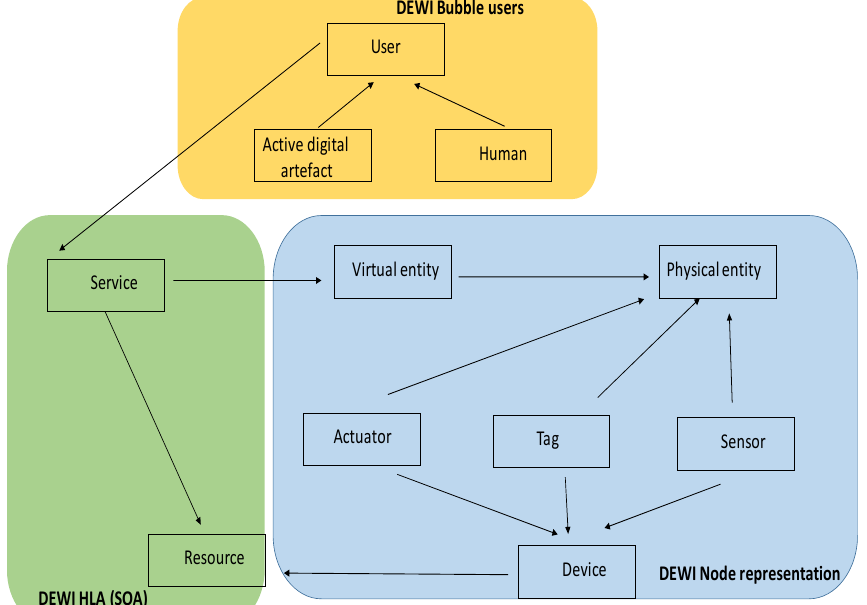
Figure 20. Mapping DEWI HLA to the IoT